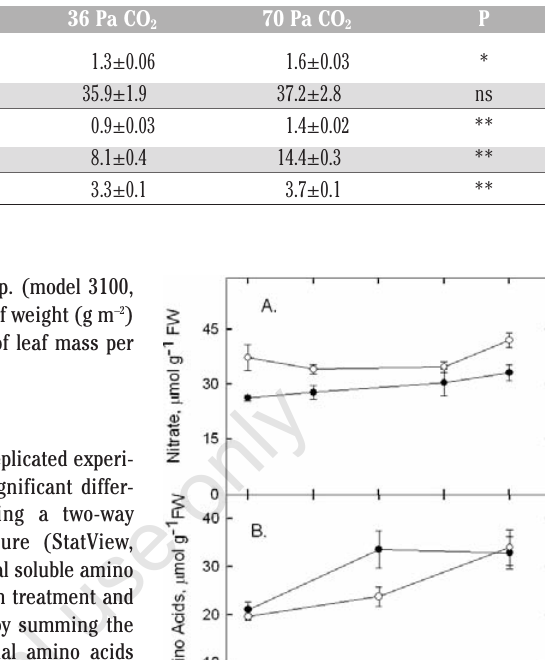
Table 1. Effects of CO enrichment on leaf N constituents and on plant growth parame- 2 ters. Soybean plants grown for 25 days using ambient and elevated CO treatments as 2 described under Design and methods. Soluble protein and Chl (a+b) were analyzed using the central lobe of the third trifoliolate leaf of soybean or the most recently collared leaf of wheat. Leaf area and total above ground biomass are for whole plants. Values are means ± SE for 5 replicate samples. * and ** are for P ≤ 0.05 and 0.01, respectively.